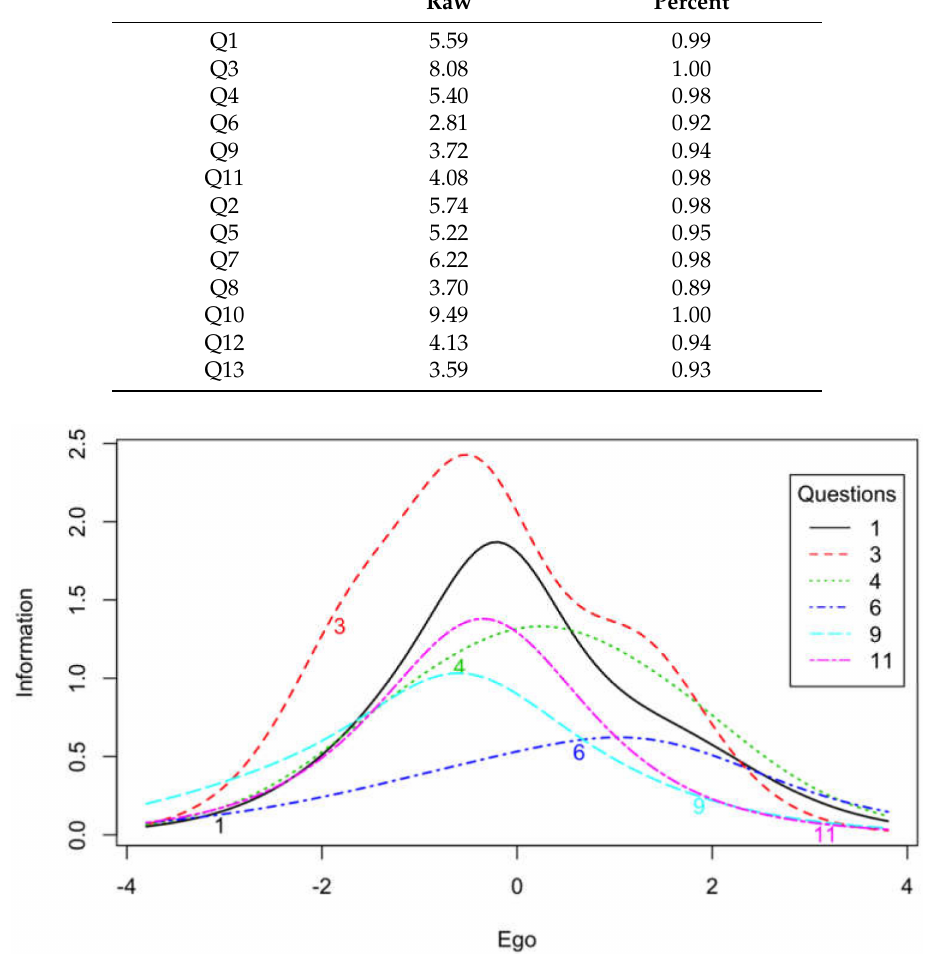
Figure 2. Item information curves for ego